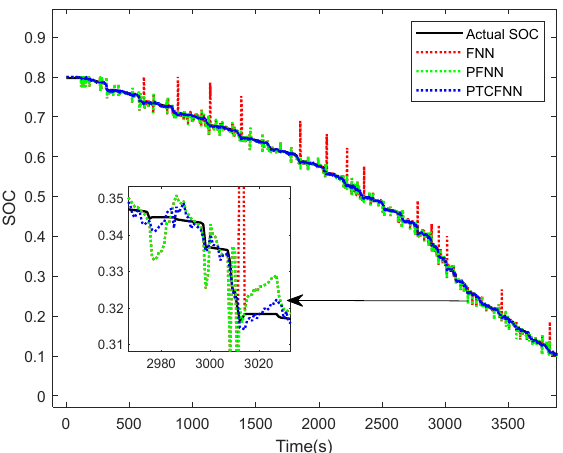
Figure 13. SOC estimation during dynamic current.